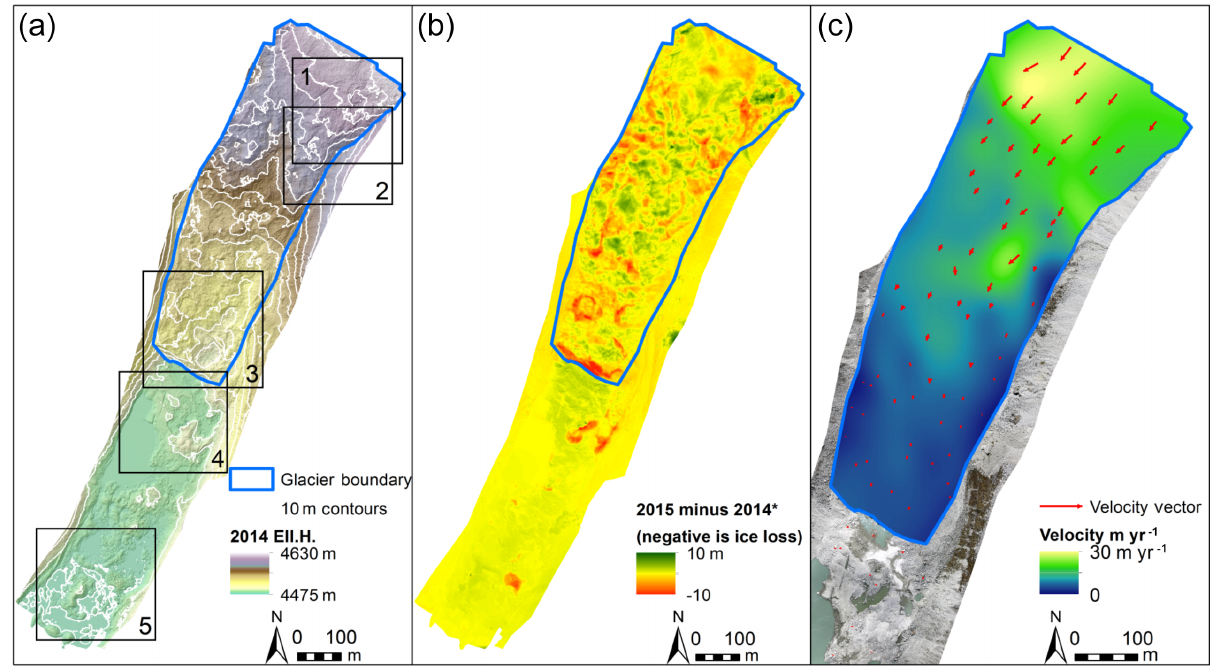
Figure 7. 2014 SfM DEM elevations in GPS ellipsoid height (Ell.H.) (a) Vertical change in elevation from 23 July 2014 to 28 July 2015. (b) Glacier surface velocity tracks and interpolated velocity surface (c) . Numbered extent boxes depict locations of Fig. 9 (1) right panels; Fig. 11 top panels (2); Fig. 9 left panels and Fig. 11 lower panels (3); Fig. 13 left panels (4); Fig. 13 right panels (5). ∗ Note: (c) values are truncated to ± 10m for display purposes (see Fig. 8).